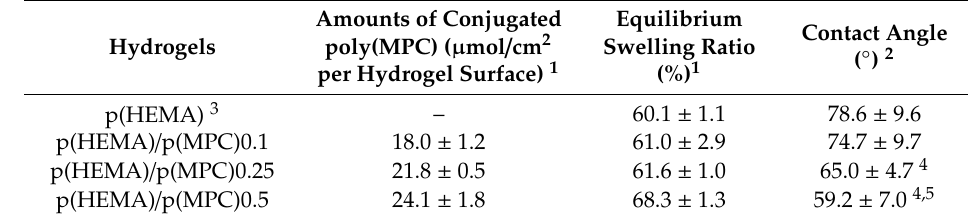
Table 1. Characteristics of the poly(2-methacryloyloxyethyl phosphorylcholine)-surface-functionalized